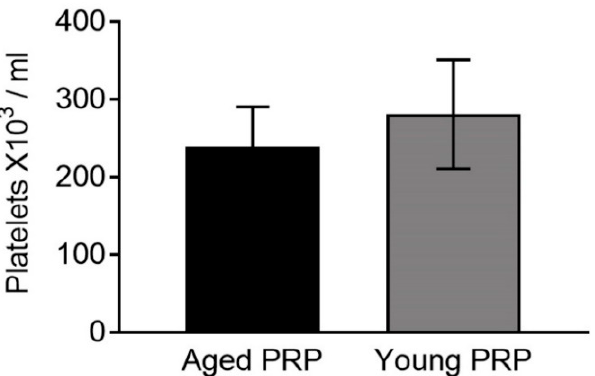
Figure 1. Platelet concentration of the two platelet-rich plasma (PRP) groups. Error bars = standard deviation.